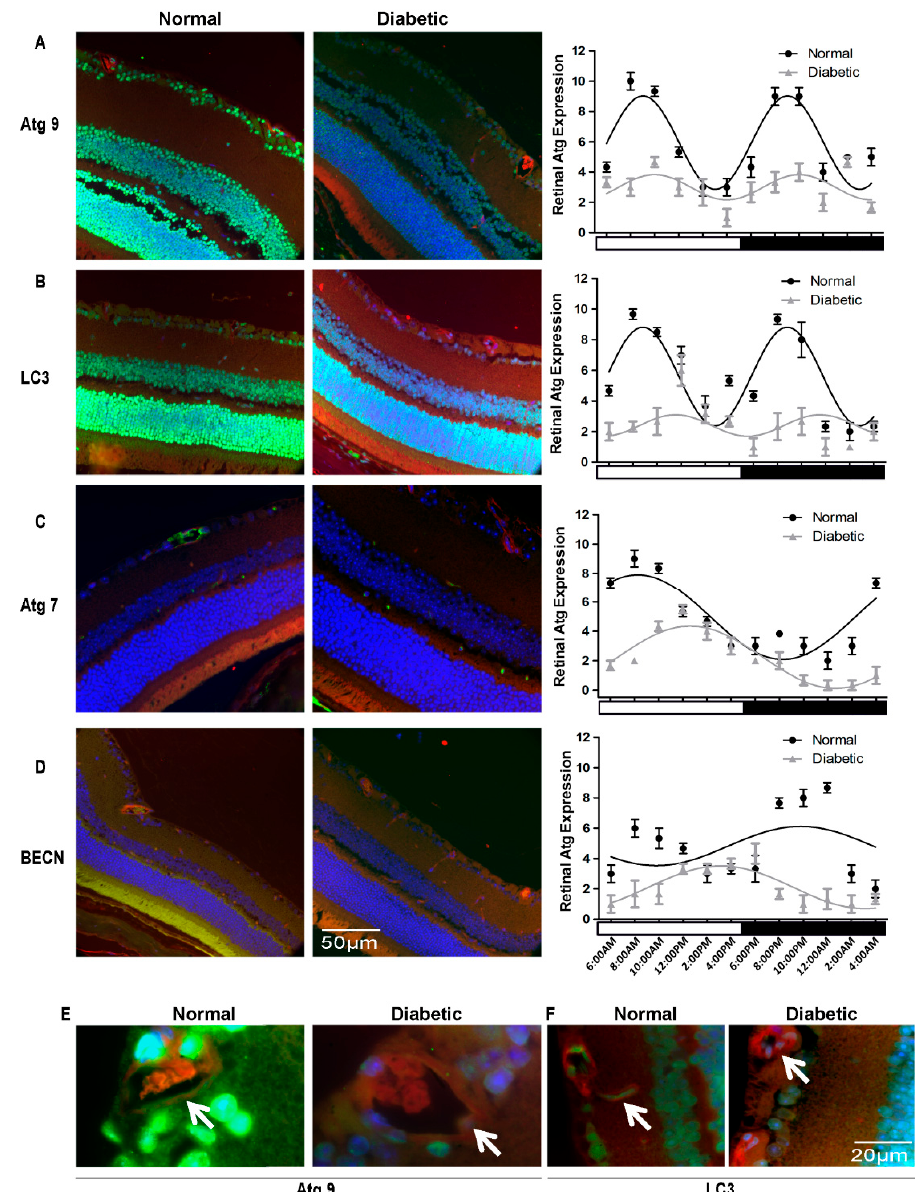
Figure 7. Impairment of diurnal rhythmicity of autophagy in T2D rats. Eyes were collected from 6.5-month old BBZDR / wor type 2 diabetic rats with 4-month duration of diabetes and the normal age-matched rats selected as controls. Immunostaining demonstrated a dramatic decrease in amplitude of diurnal rhythmicity of autophagic protein expression in the retina of the diabetic animals compared to normal rats. Representative micrographs of immunostained sections at 8:15am are shown for ( A ) ATG9, ( B ) LC3 ( C ) ATG7 ( D ) Beclin1 (BECN). Autophagy protein expression is green, TRITC agglutinin for vessels red and DAPI nuclear staining blue. The arrows indicate autophagy protein localization to retinal vessels. RGC, retina ganglion cell; INL, inner nuclear layer; OPL, outer plexiform layer; ONL, outer nuclear layer; RPE, retinal pigment epithelium. ATG7 and Beclin1 displayed phase-shifting in the diurnal oscillation ( C ) and ( D ) respectively. Loss and phase-shifting of diurnal rhythmicity in diabetic retinopathy is demonstrated in single cosine plot with ordinary least square fitted ( p < 0.01, n = 10). High magnification images confirmed the loss of autophagy proteins ATG9 and LC3 in the retinal vasculature ( E ). All animals were maintained in a standard 12/12-h light/dark phase with lights ON at 6:00AM and lights OFF at 6:00PM. The error bars in the circadian plots represent the mean+SEM and diurnal oscillation had a p -value less than 0.05.